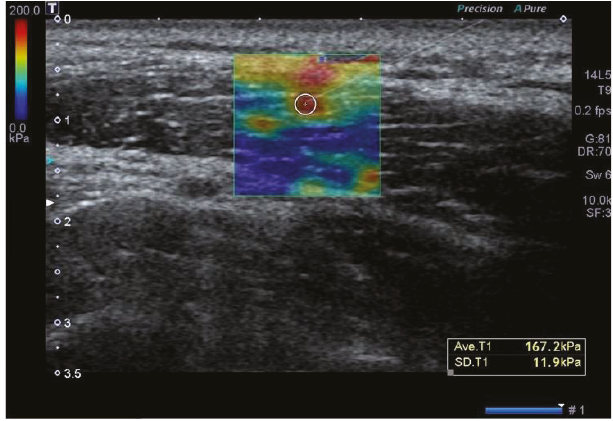
Figure 2. Ultrasound-guided myofascial trigger point (MTrP) injection . Increased stiffness at the MTrPs on shear wave elastography is confirmed on shear wave elastography. The injection was followed at the point where the stiffness increased mostly in the region of